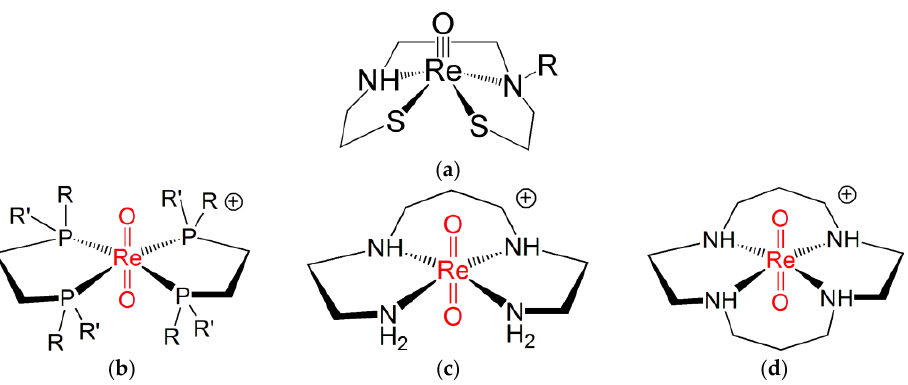
Figure 7. The molecular structures of ( a ) an example of sp Re(V) oxo complex and of octahedral trans )-dioxo Re(V) complexes with ( b ) diphosphines and ( c ) acyclic and ( d ) cyclic tetramines ligands (R, R ′ = any pendant organic substituents) [6 – 8,25,46,47].